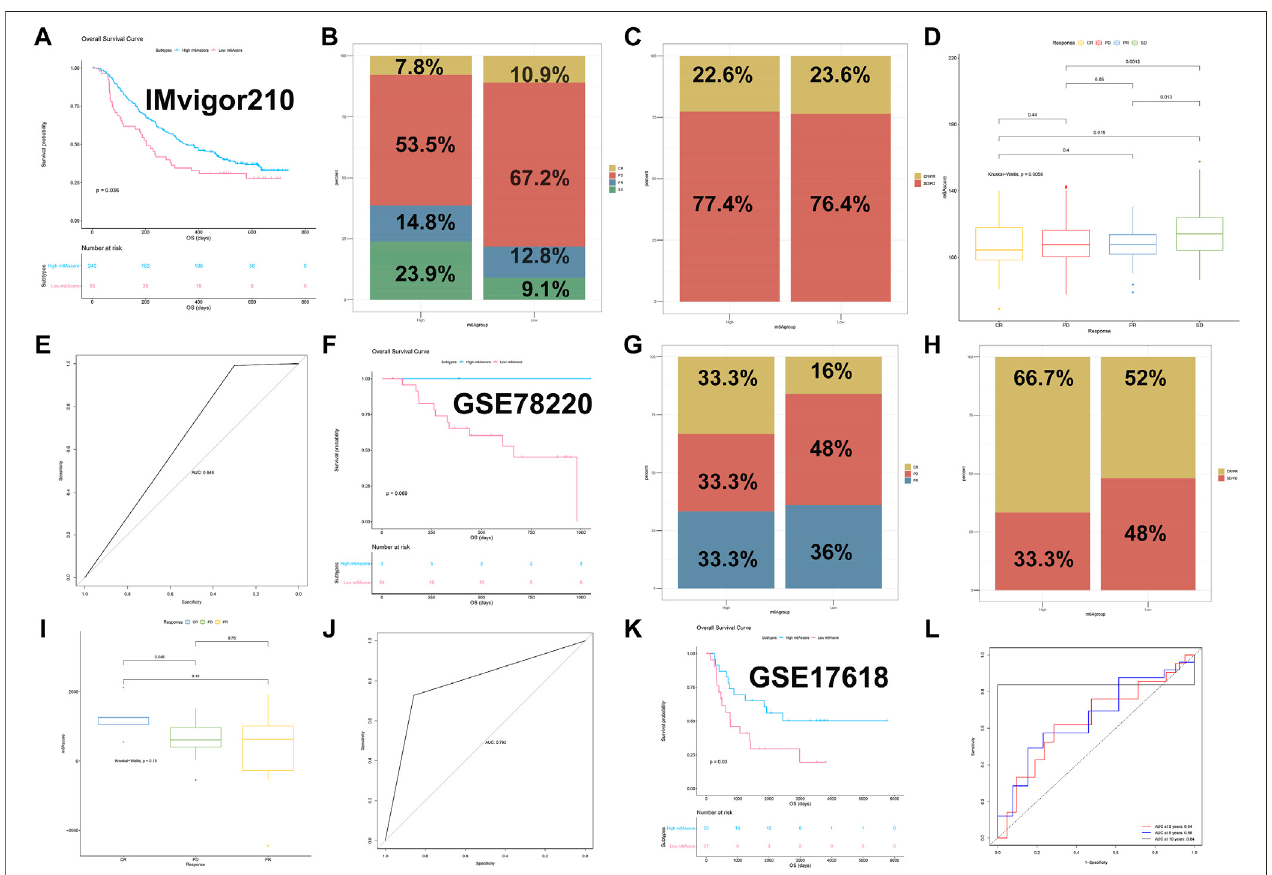
FIGURE8 | The m6Ascorepredicted immune response in immunotherapy datasets and validationof m6Ascore. (A) Survivalplot ofhigh and lowm6A score in the IMvigor210 dataset ( p = 0.036); (B) relative percent of immune responses in high and low m6A score in the IMvigor210 dataset; CR, complete response; PR, partial response; SD, stable disease; PD, progressive disease; (C) relative percent of CR/PR and SD/PD in high and low m6A score in the IMvigor210 dataset; CR, complete response, PR, partial response, SD, stable disease, PD, progressive disease; (D) box plots of m6Ascore in different immune responses in the IMvigor210 dataset; (E) ROCcurveforpredictionofimmuneresponseintheIMvigor210dataset; (F) survivalplotofhighandlowm6AscoreintheGSE78220dataset( p =0.069); (G) relative percent ofimmune responses in high and low m6A score in the GSE78220 dataset; CR, complete response; PR, partial response; PD, progressive disease; (H) relative percentofCR/PRandSD/PDinhighandlowm6AscoreintheGSE78220dataset;CR,completeresponse;PR,partialresponse;PD,progressivedisease; (I) boxplots of m6A score in different immune responses in the GSE78220 dataset; (J) ROC curve for prediction of immune response in the GSE78220 dataset; (K) survival plot of high and low m6A score in the GSE17618 dataset ( p = 0.030); and (L) ROC curve for prediction of the 3-, 5-, and 10-year survival of STS in the GSE17618 dataset.